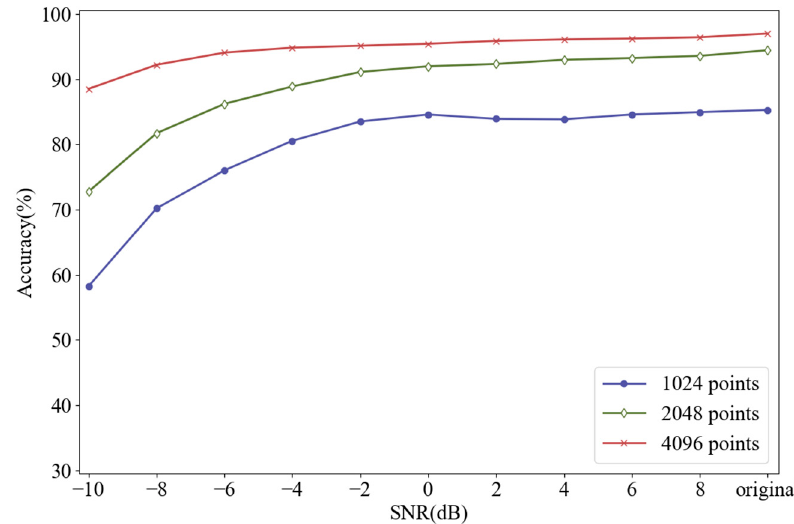
Figure 8. Diagnosis results of FDFM algorithm under different SNRs when the number of sampling points is 1024, 2048 and 4096 respectively.